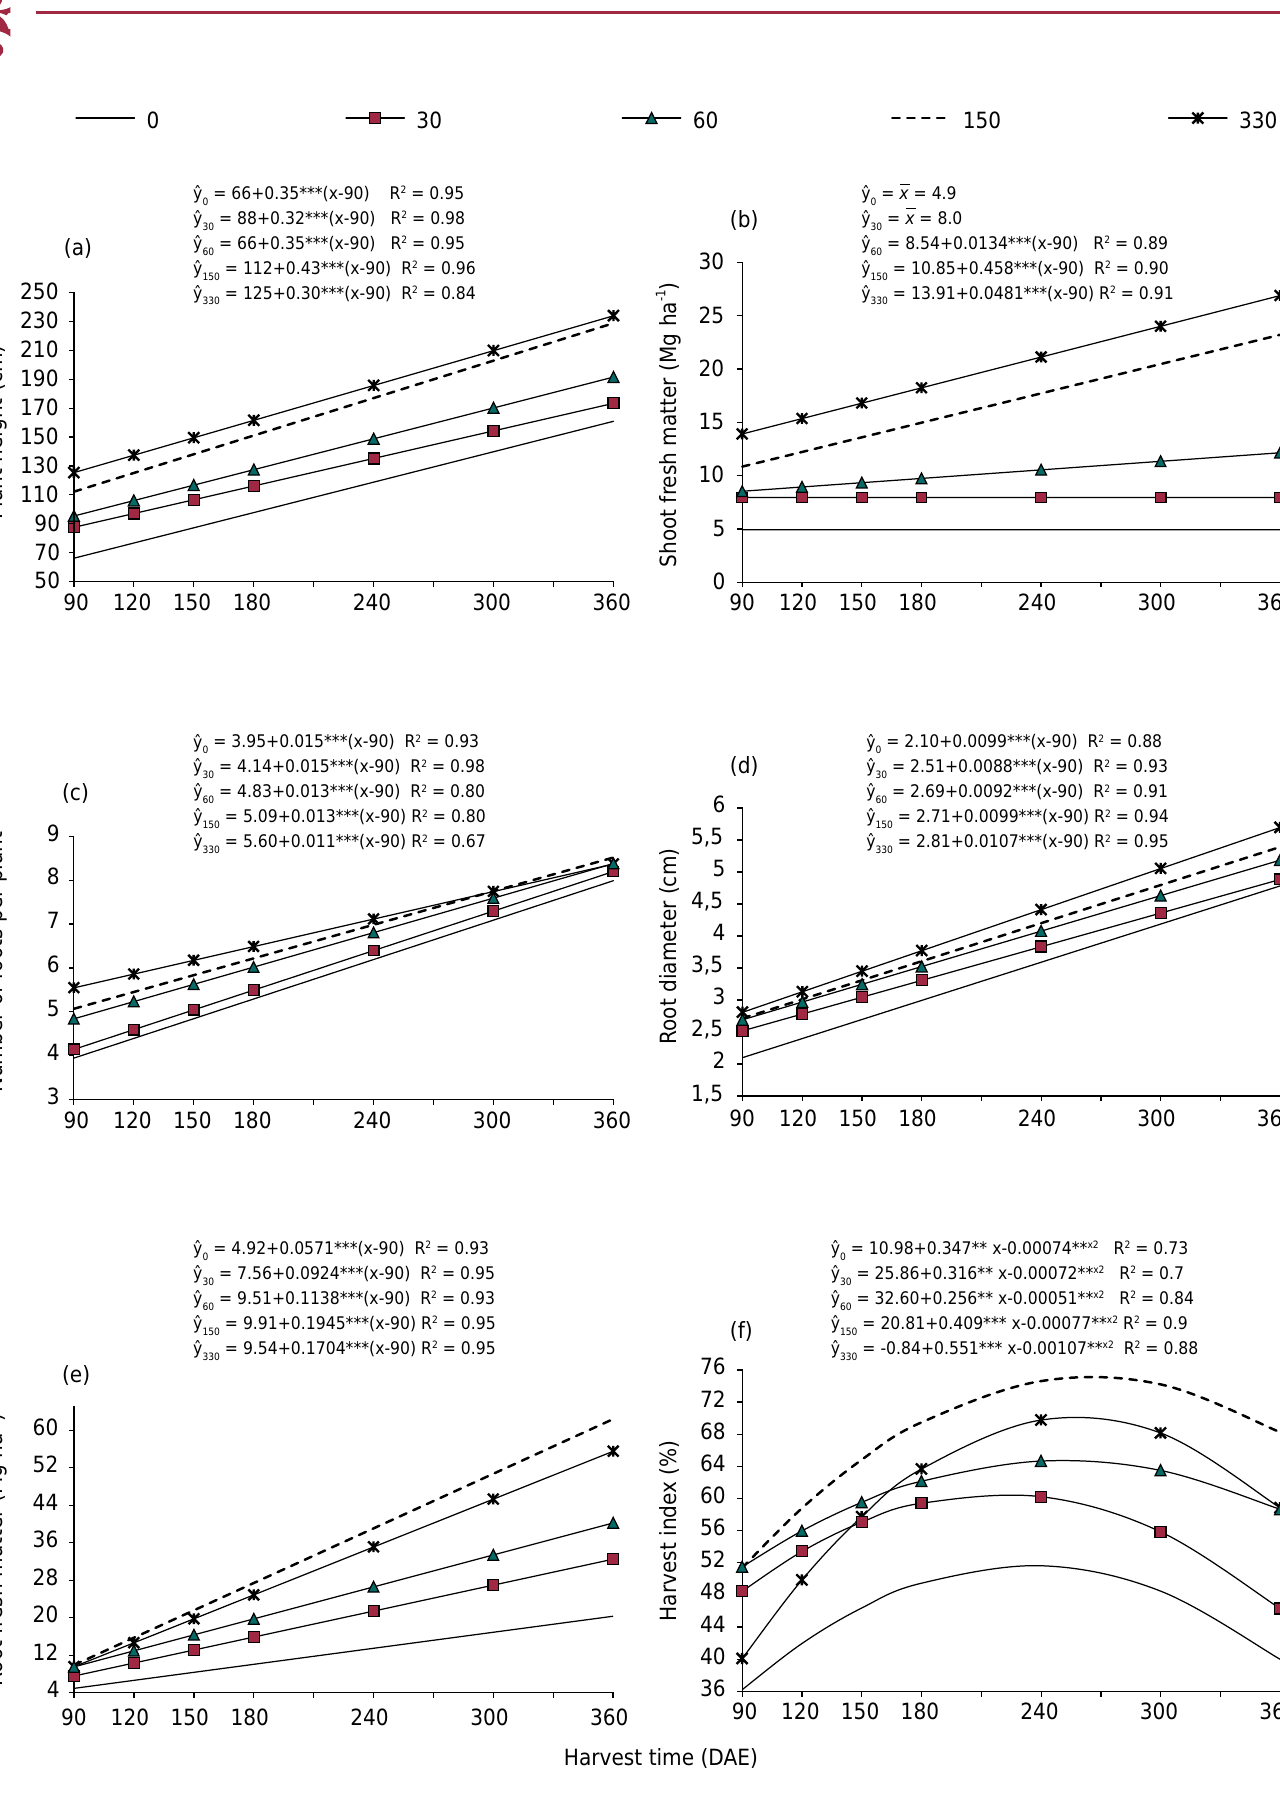
Figure 2. Production components of cassava, cv. Aciolina, for harvest time - (a) plant height; (b) shoot fresh matter yield; (c) number of roots per plant; (d) root diameter; (e) root fresh matter yield; and (f) harvest index for different levels of nitrogen topdressing. ** and ***: significant at 1 and 0.1 % probability by the